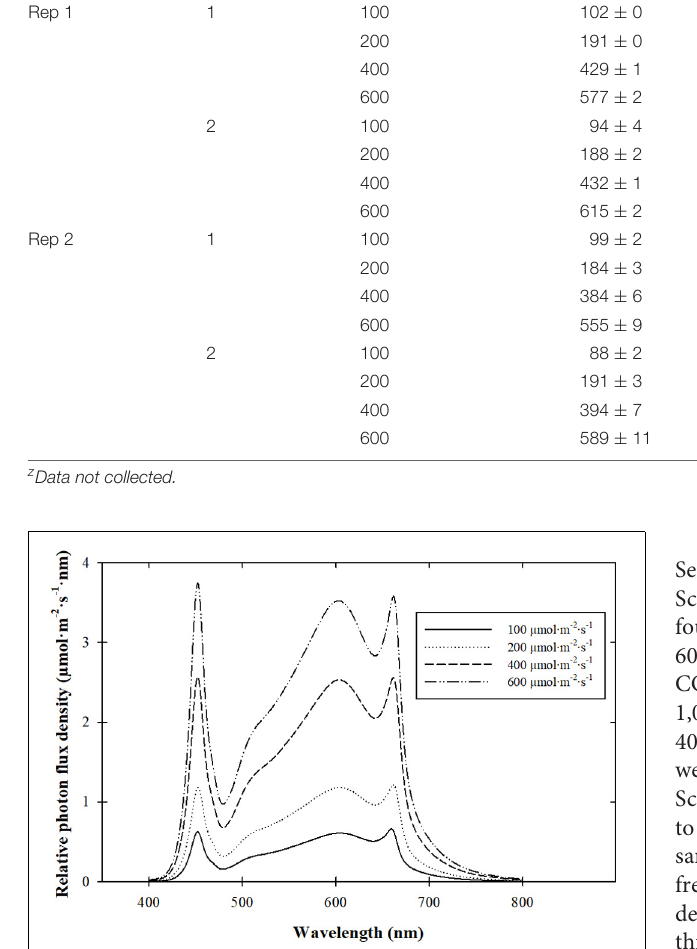
FIGURE 1 | Spectral quality of light-emitting diode (LED) fixtures providing 20:40:40 blue:green:red radiation ratios (%), a red:far-red ratio of 13:1, and target radiation intensities of 100, 200, 400, or 600 µ mol · m - 2 · s − 1